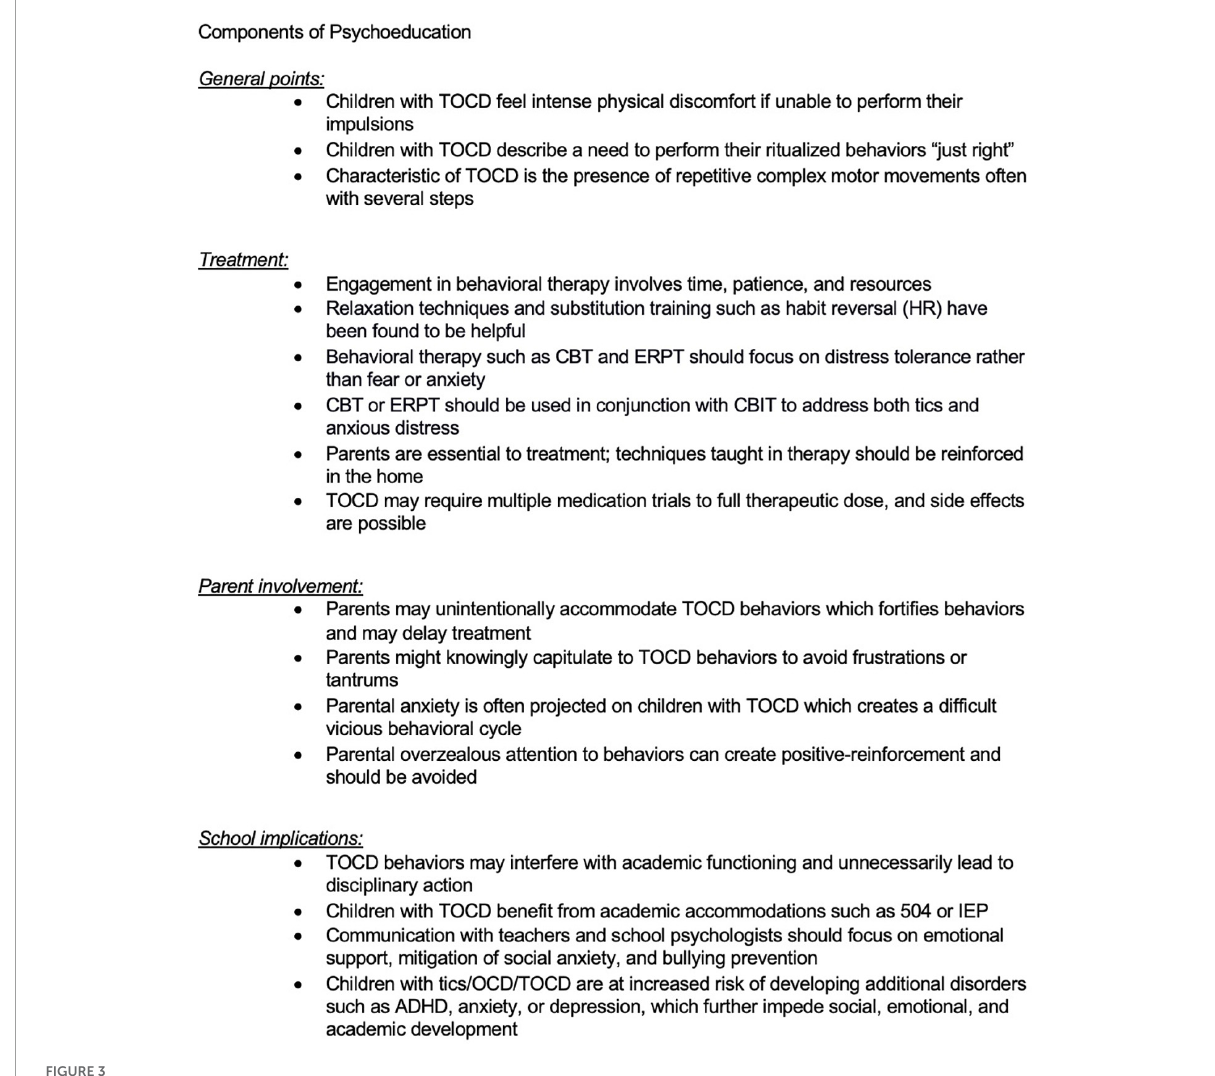
FIGURE3 Components of psychoeducation for children with